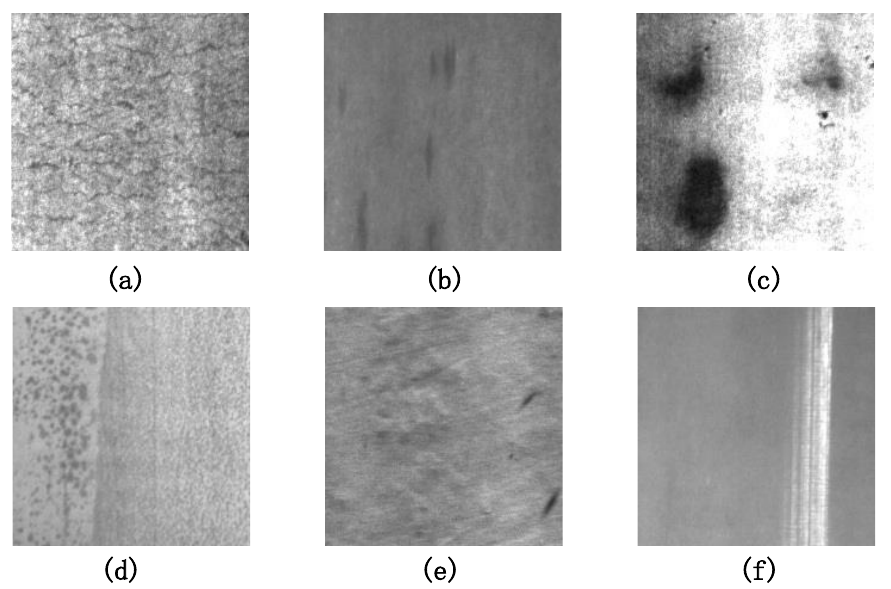
Figure 1. Some samples of Metallic surface defects. ( a ) Crazing. ( b ) Inclusion. ( c ) Patches. ( d ) Pitted surface. ( e ) Rolled in scale. ( f )